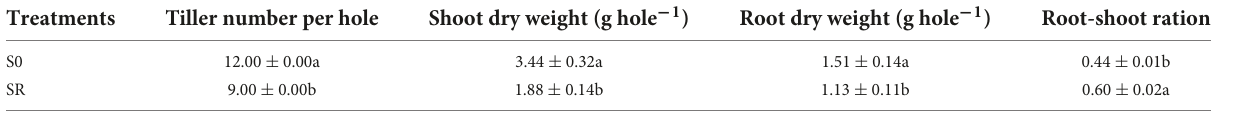
TABLE 1 Effects of rice straw on rice plant growth.